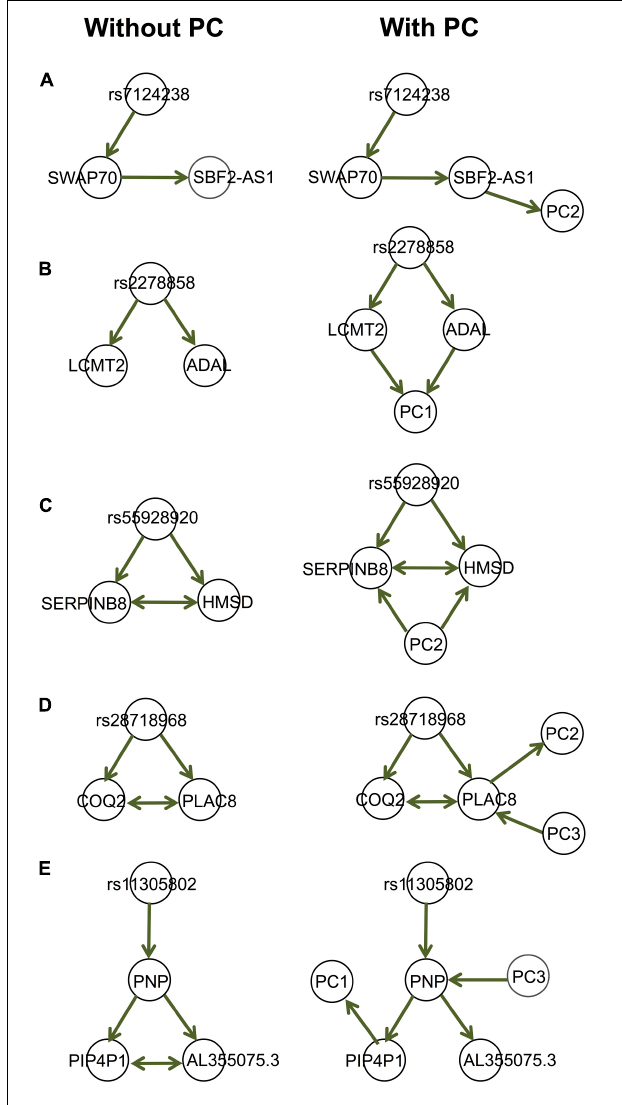
FIGURE 5 | Examples of the GEUVADIS data analysis accounting for confounding variables. Each of the five sets in (A – E) contains an eQTL and multiple genes. These genes have been identified by GEUVADIS to be significantly associated with the corresponding eQTL. We derived the principal components (PCs) from the whole-genome gene expression matrix and identified the PCs that are significantly associated with the eQTLs or genes. We applied MRPC to the eQTL-gene set without and with the associated PCs. The PCs can have diverse relationships with the